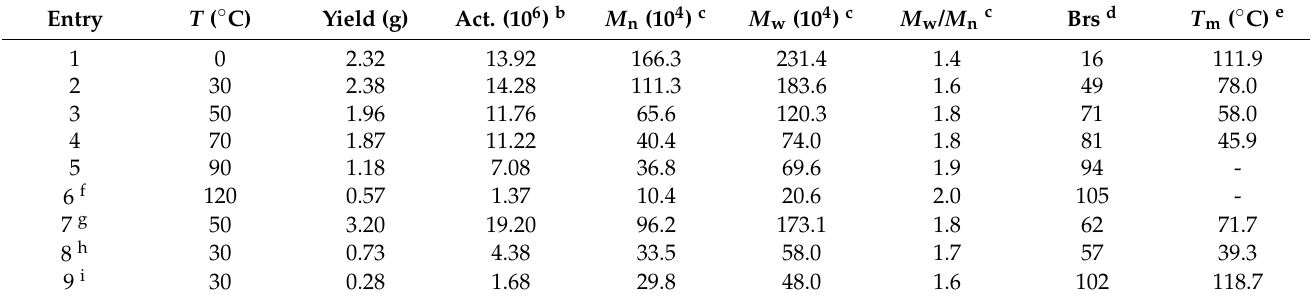
Table 2. Ethylene polymerization catalysed by Ipty/ i Pr-Ni a .